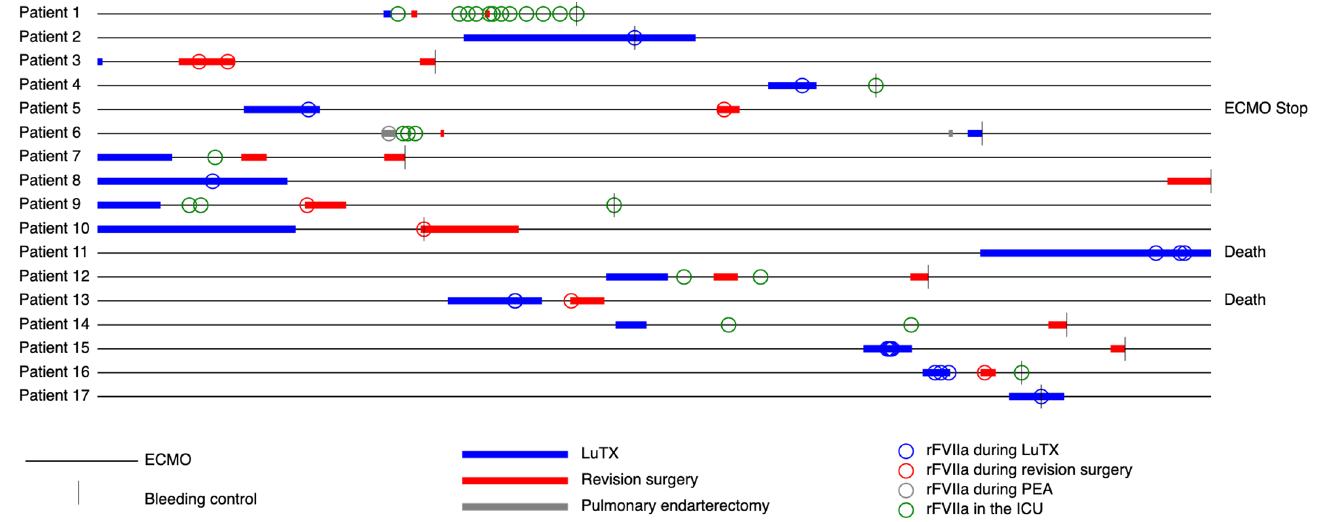
Figure 2. Individual administrations of rFVIIa surgeries for bleeding control depicted on a normal- ized ECMO timeline. The individual period of uninterrupted ECMO therapy is represented by a horizontal line for each patient. The lines are normalized over all patients, such that all lines have the same length. Horizontal bars represent surgical interventions and are colored by the type of surgery. Colored rings represent the administration of rFVIIa and vertical lines the time of bleeding control. In three patients, hemorrhage could not be controlled during ECMO therapy. Of these, one could be weaned off ECMO therapy and two patients succumbed (one in the OR, one in the ICU). ECMO = extracorporeal membrane oxygenation; rFVIIa = recombinant, activated Factor VII; LuTX = lung transplantation; PEA = pulmonary endarterectomy; ICU = intensive care unit.